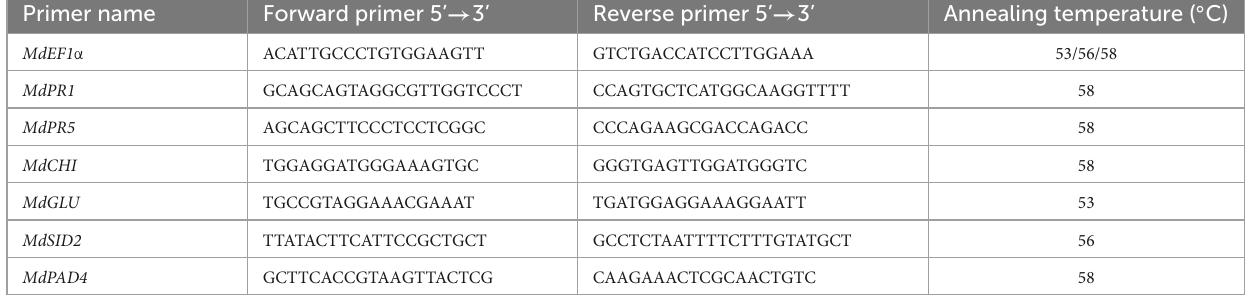
TABLE 1 Specific primers used for quantitative real-time PCR (qPCR) to analyze gene